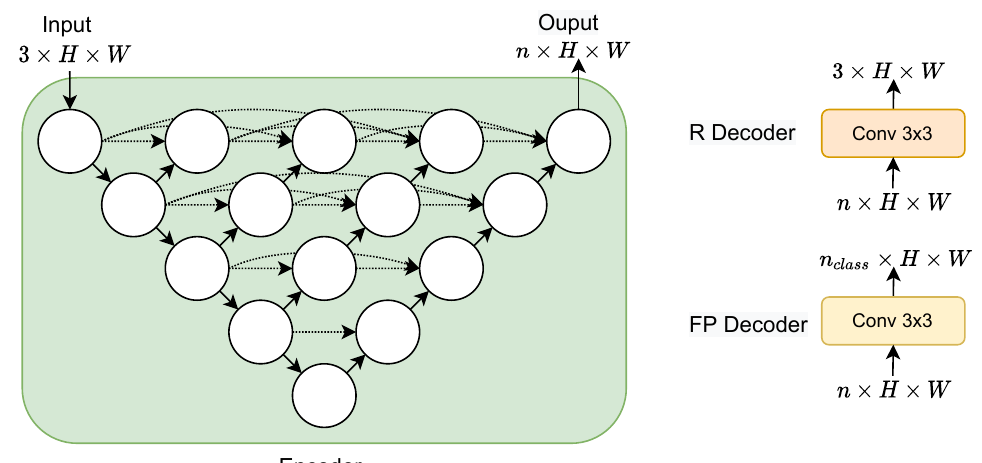
Figure 2. The architecture of Encoder, R Decoder, and FP Decoder in the proposed framework. n class denotes the number of facial parts labeled in the